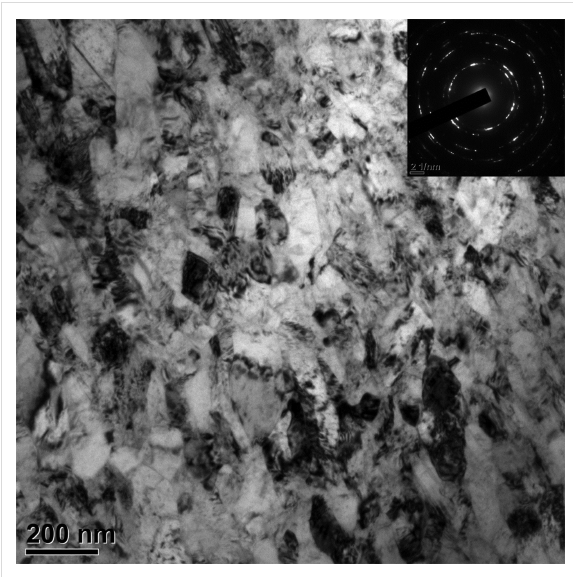
Figure 2: (a) A typical TKD orientation map of the HPT Cu–Zn alloy. The inverse pole figure coloring scheme in the inset is utilized to code the orientation map, in which grains with {001}, {101}, and {111} planes parallel to the sample surface are indicated by red, green and blue, re- spectively. The black, silver and red boundary lines represent high- angle grain boundaries (>15°), low-angle grain boundaries (2–15°), and Σ 3 twin boundaries, respectively. Grains highlighted with white squares and labeled with A, B and C present three typical twin struc- tures that correspond to those shown in Figure 3a–c, respectively. In B and C, twins intersect with triple junctions (highlighted by circles), which is a common phenomenon in all orientation maps. (b) Pole figures of the area presented in (a). Only a weak texture is observed